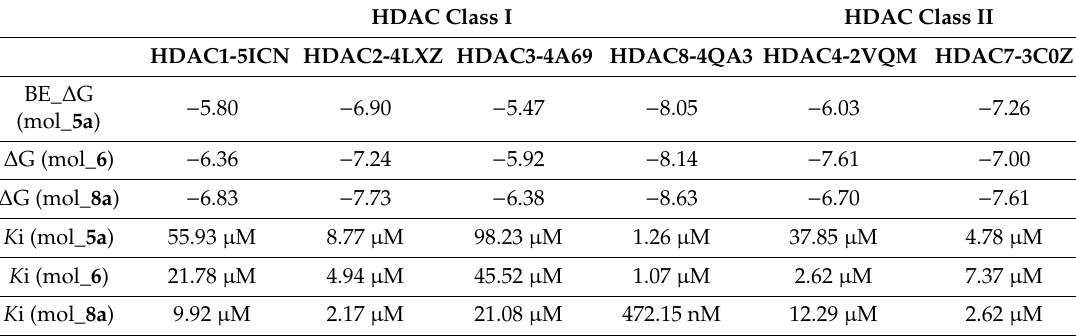
Table 2. Docking results, expressed in term of binding free energy ( ∆ G, kcal / mol) and calculated inhibition constant ( K i, nM or µ